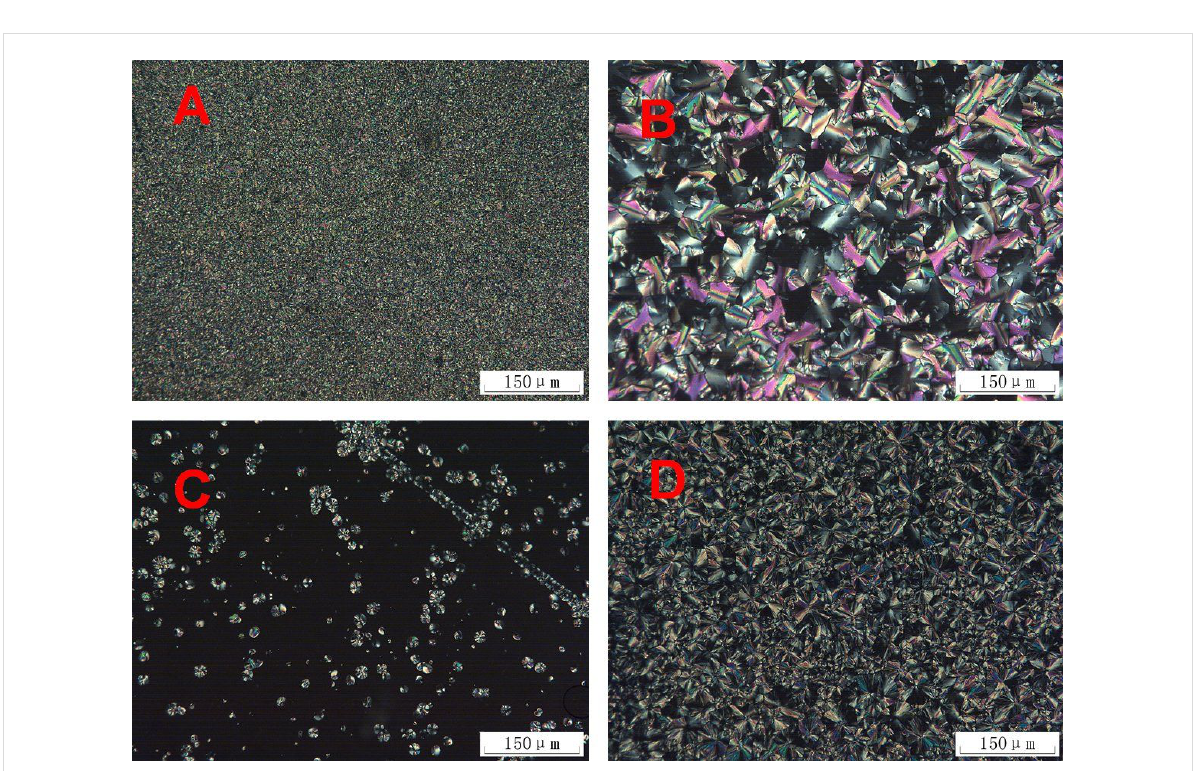
Figure 2: Optical photomicrographs of the triphenylene DLC trimers. (A) 4 at 70 °C; (B) 5b at 85 °C; (C) 5c at 100 °C; (D) 5c at 75